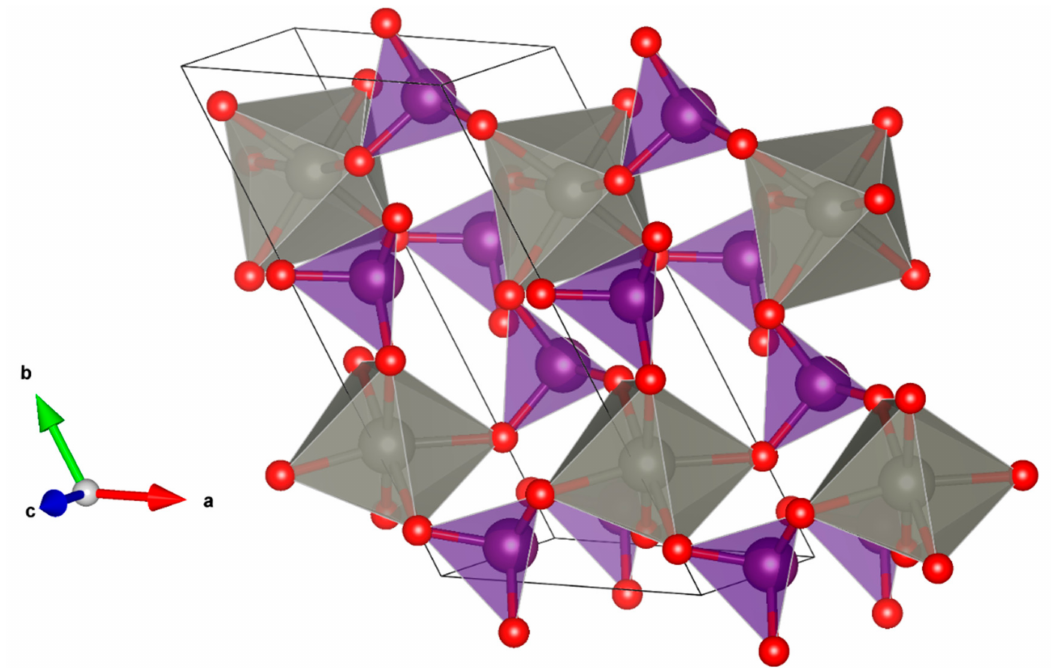
Figure 1. Crystal structure of Zn(IO 3 ) 2 . ZnO 6 octahedral units are shown in grey and IO 3 trigonal pyramidal units are shown in purple. Small red circles are oxygen atoms. The monoclinic unit cell is shown with black solid